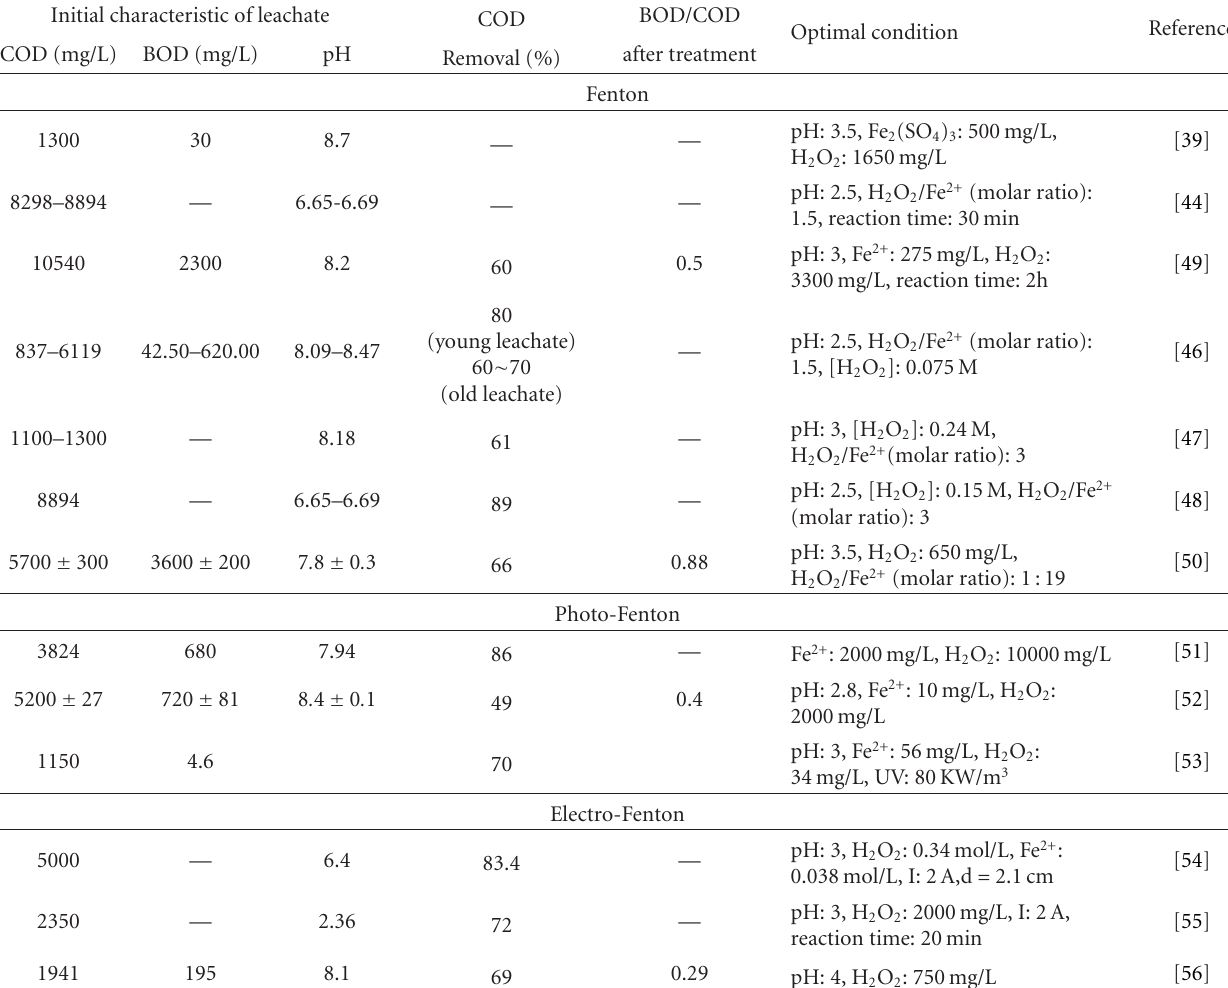
Table 4: Fenton, photo-Fenton, and electro-Fenton treatments of